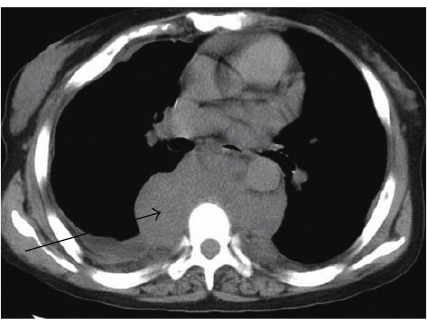
Figure 6: Post-treatment CT result suggests bilateral pleural effu- sions were largely not evident, however soft masses surrounding the vertebrae still exist. On March, 6, 2011, the CT scan was performed following treatment. The left arrow indicated a rounded soft tissue mass surrounding the